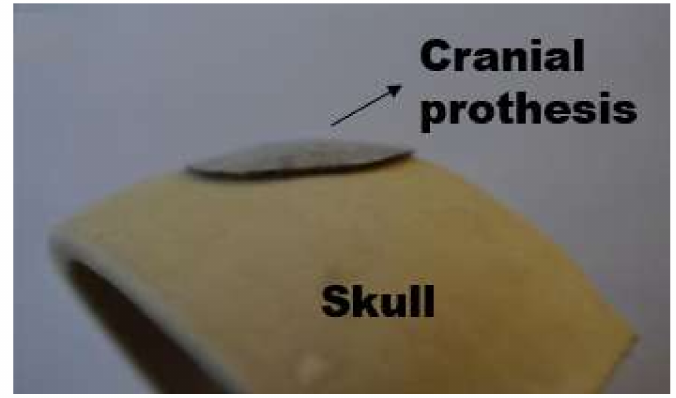
Figure 6. Single piecewise linear scanning paths: front view of the laser formed cranial